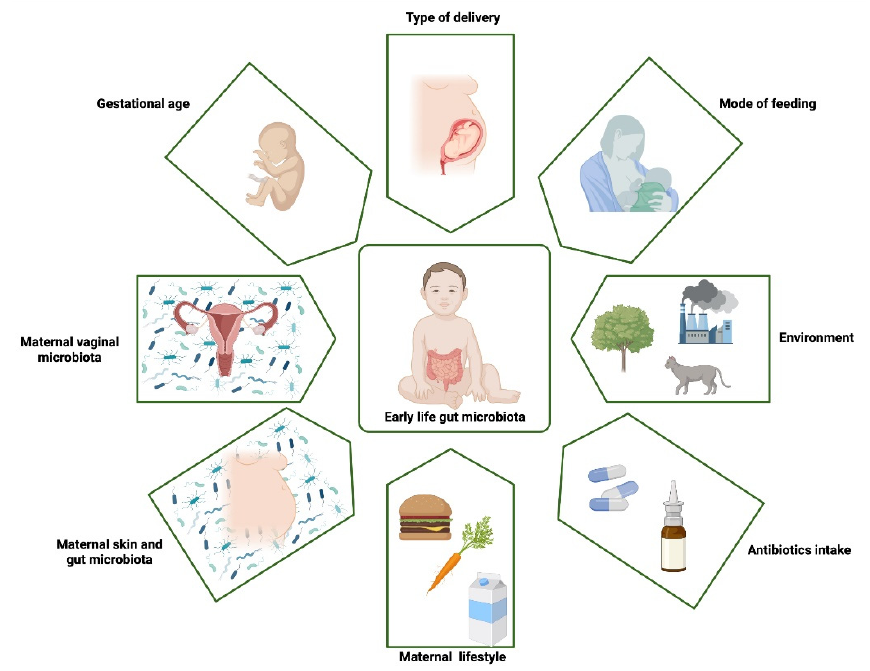
Figure 1. The main factors that influence early-life gut microbiota. The first steps in gut colonization probably start already in utero and are influenced by maternal gut microbiota. More likely, a new- born is specifically colonized during birth, and the composition of bacteria localized in the intestine depends on the type of delivery. In the first two years of life, the gut microbiota composition is influenced by multiple factors, mainly mode of feeding, environment and antibiotics intake. Created with biorender.com, accessed on 24 September 2022.